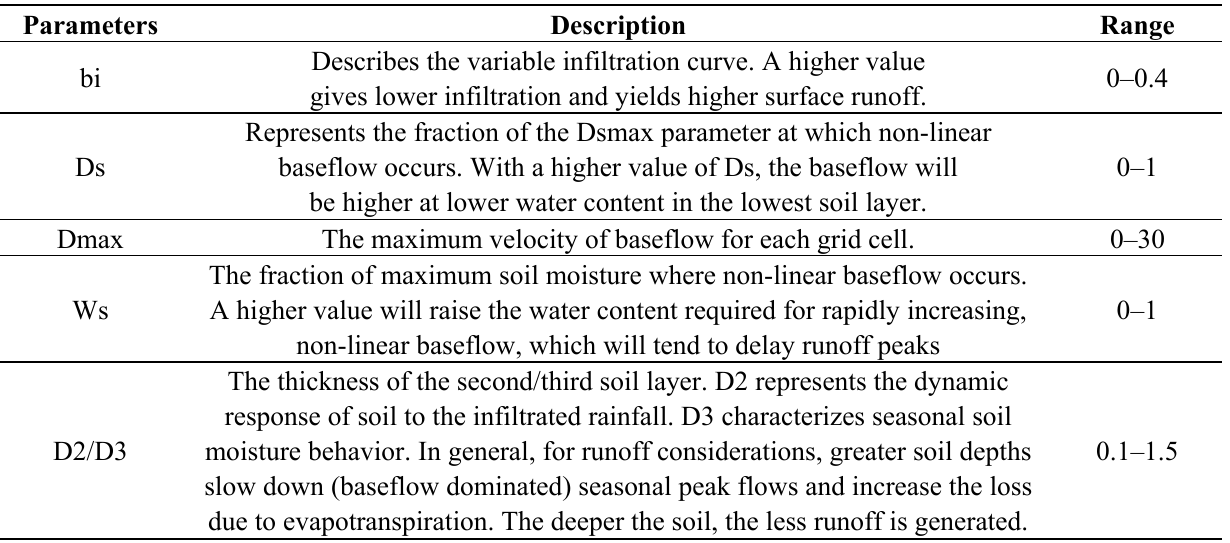
Table 1. Parameters that need to be calibrated in the VIC model.